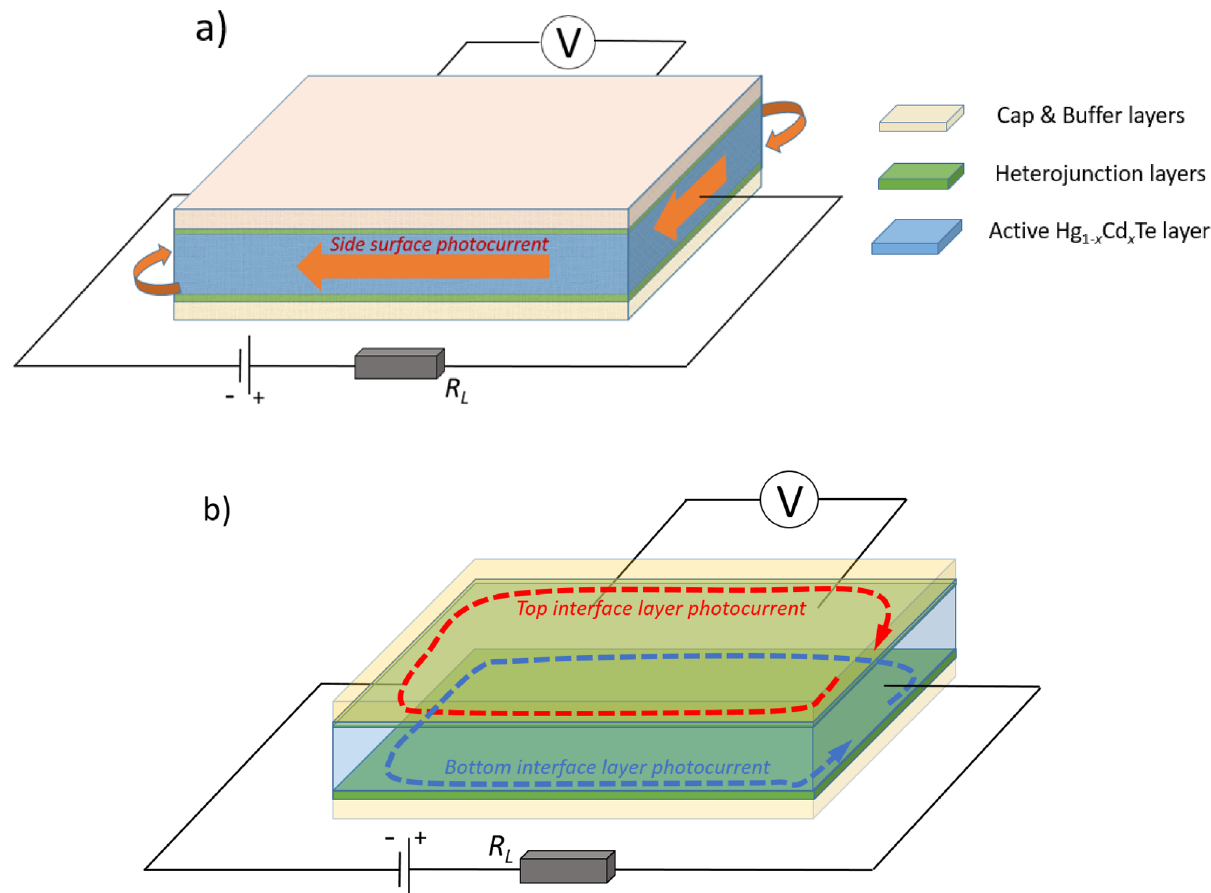
Figure 4. Possible options for the element of the structure responsible for the odd photoconductivity component appearance. ( a ) The chiral photocurrent flows along the topological film–vacuum interface; ( b ) chiral photocurrents flow along the edges of the topological film–trivial buffer/cap-layer